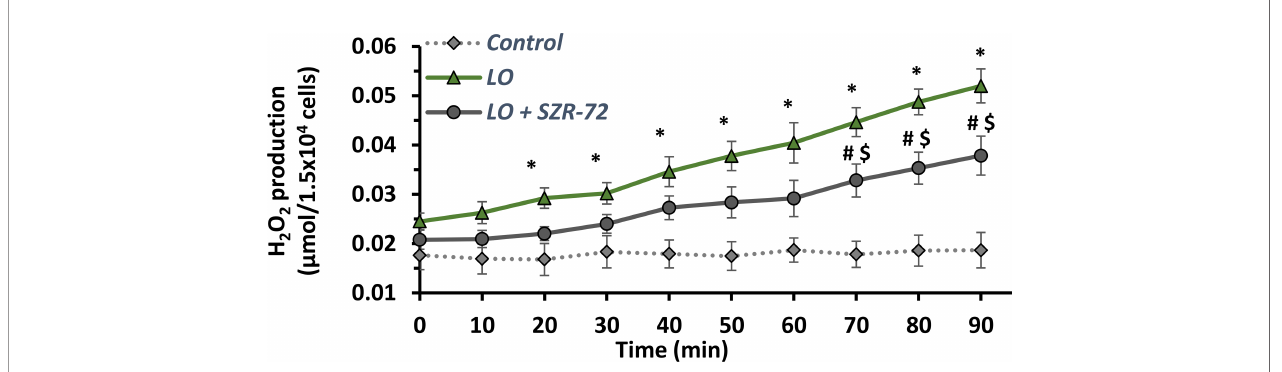
FIGURE 9 | Time course of H 2 O 2 production of neutrophil granulocytes isolated from rats treated with physiological saline, LO or LO+300 mg/kg SZR-72. Values represent means with standard error, n=4. Two-way ANOVA was performed followed by Bonferroni post-hoc test. Statistically signi fi cant differences (p<0.05) were marked with: (*) control vs . LO; (#) LO vs . LO+SZR-72; ($) control vs . LO+SZR-72.